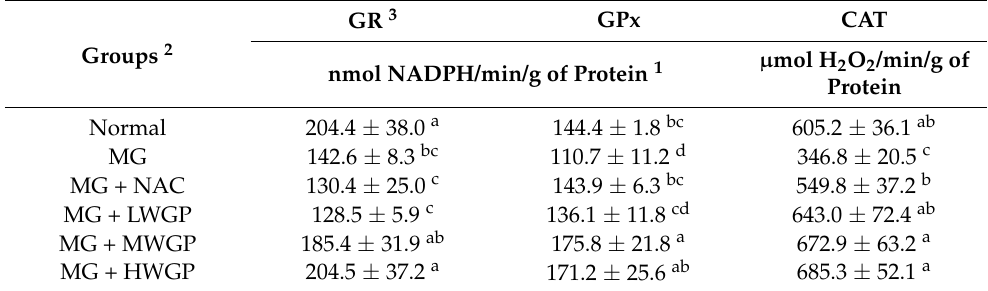
Table 3. Effects of WGP on the activities of antioxidative enzymes in the livers of MG-treated